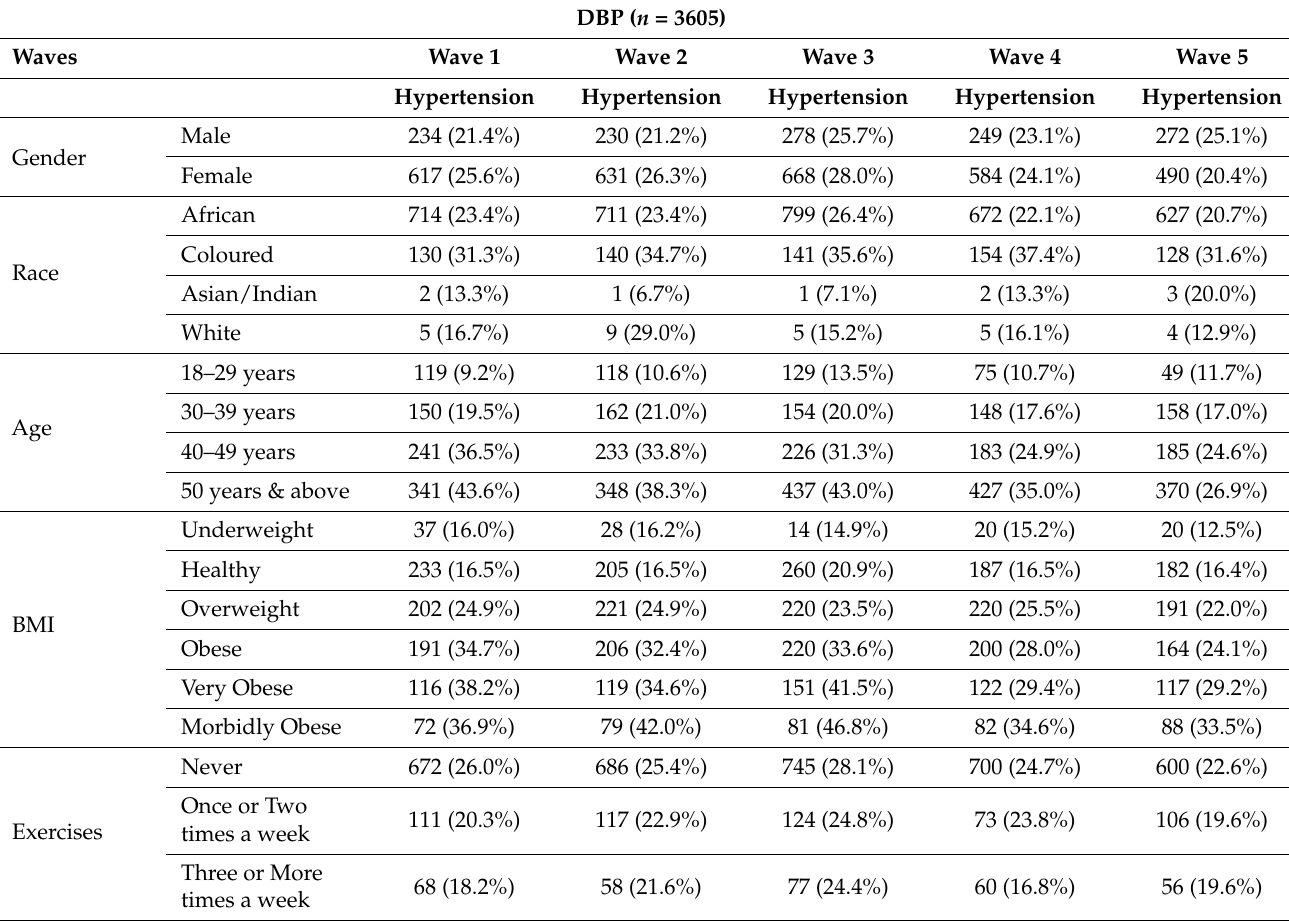
Table 4. Hypertension Prevalence among South African Adults by Demographic and Lifestyle Characteristics based on